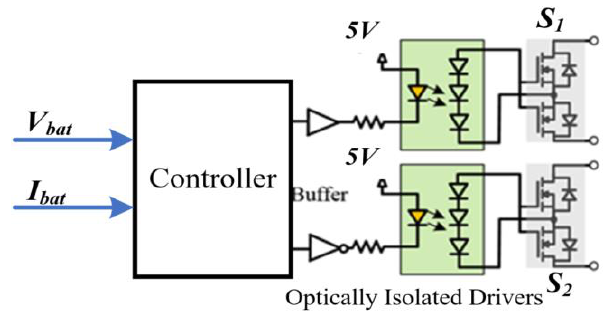
Figure 17. Bidirectional AC switch driving